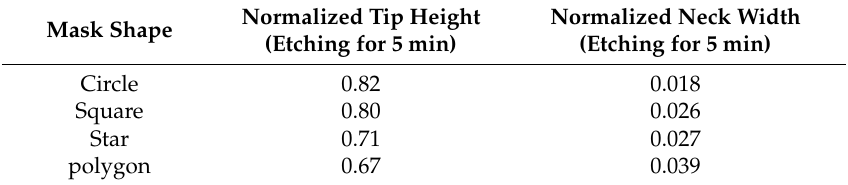
Table 1. Normalized tip heights for different masks.